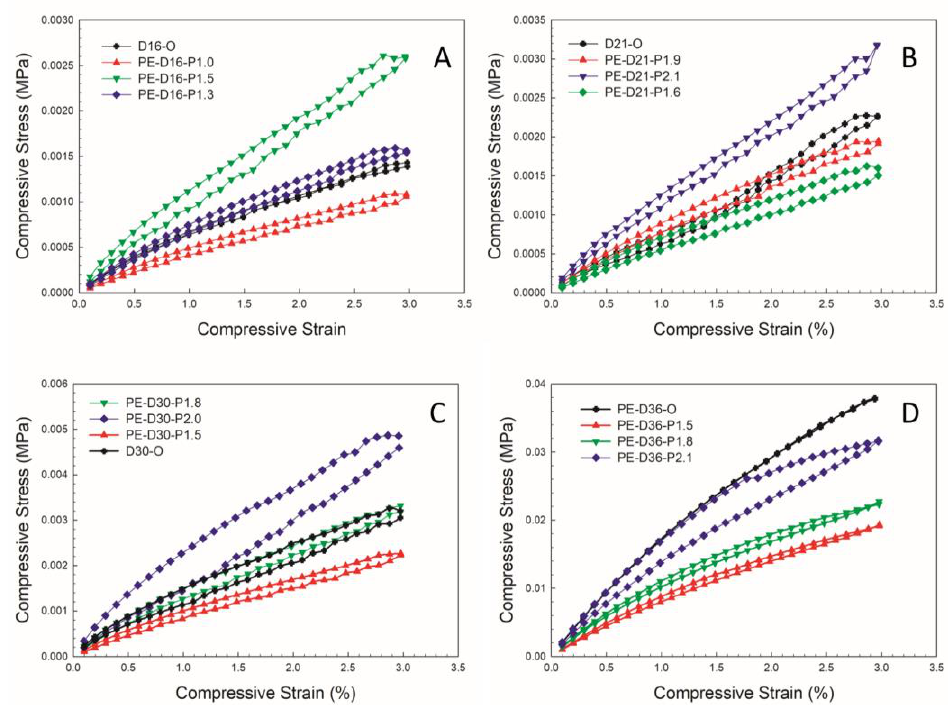
Figure 10. Compressive hysteresis loops for the auxetic and original foams based on ( A ) D16, ( B ) D21, ( C ) D30 and ( D ) D36.